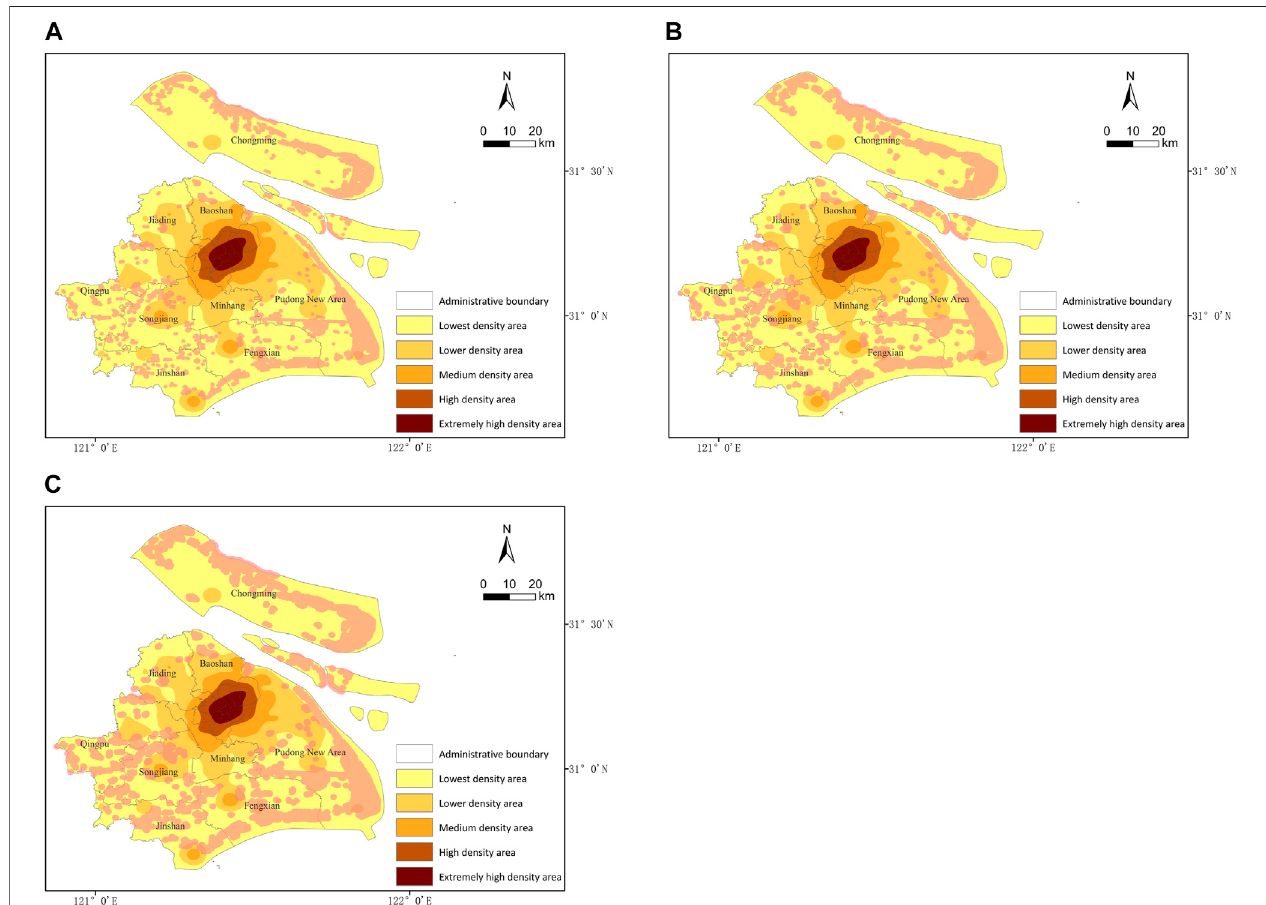
FIGURE 3 | Coverage of different radii ecological service areas of GSS. (A) 500 m, (B) 750 m, and (C) 1,000 m.